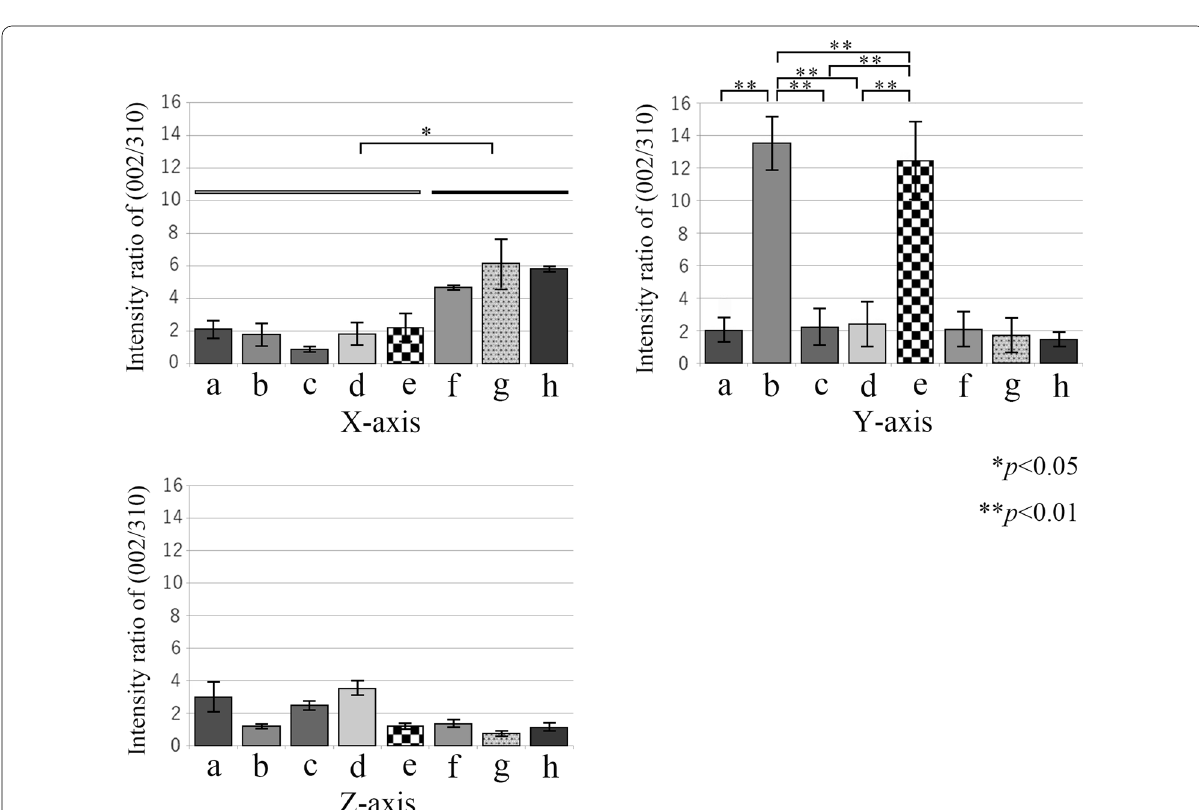
Fig. 6 Orientation of BAp c -axis in each measurement axis. The vertical axis shows the X-ray diffraction intensity ratio calculated from the (002)/ (310) peaks, and the horizontal axis shows the groups. a X -axis (mesiodistal axis) direction. b Y -axis (the long axis of the implant body) direction. c Z -axis buccolingual axis